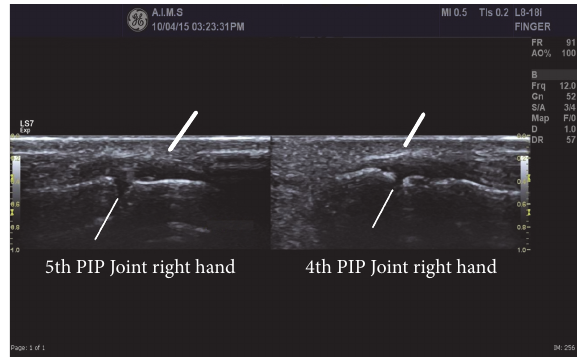
Figure 2: B-mode high resolution ultrasonography image (longi- tudinal section) of proximal interphalangeal joints showing diffuse dermal and subcutaneous oedema (thick lines) and normal joint space with no evidence of synovitis (thin